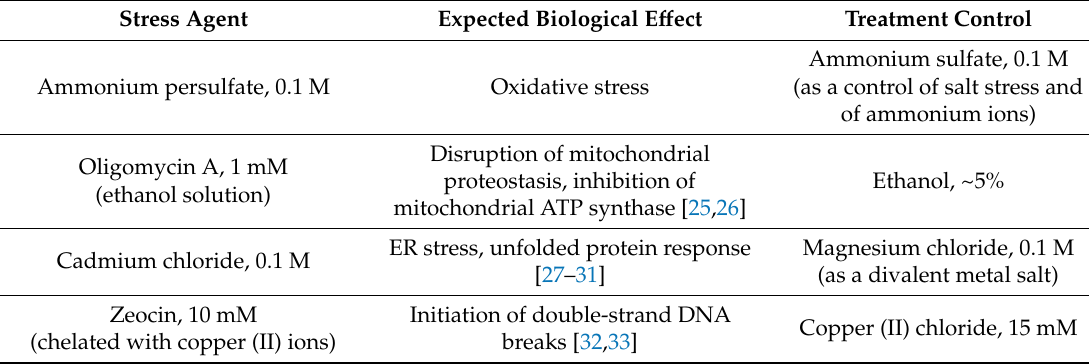
Table 1. Stress agents and controls used in experiments and stress e ff ects.